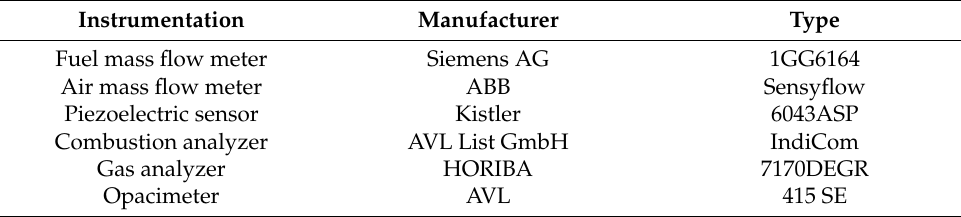
Table 2. Main equipment for engine